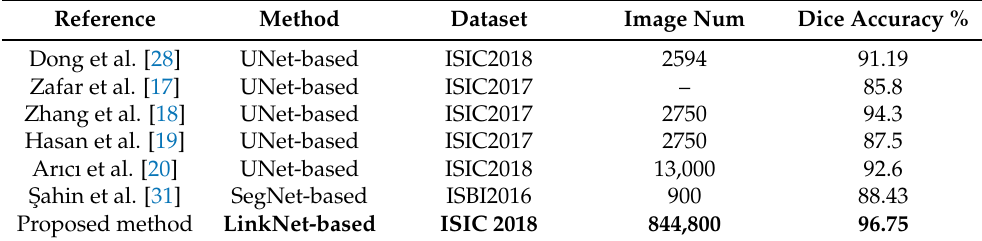
Table 7. Comparison of methods in the lesion segmentation phase with the ISIC